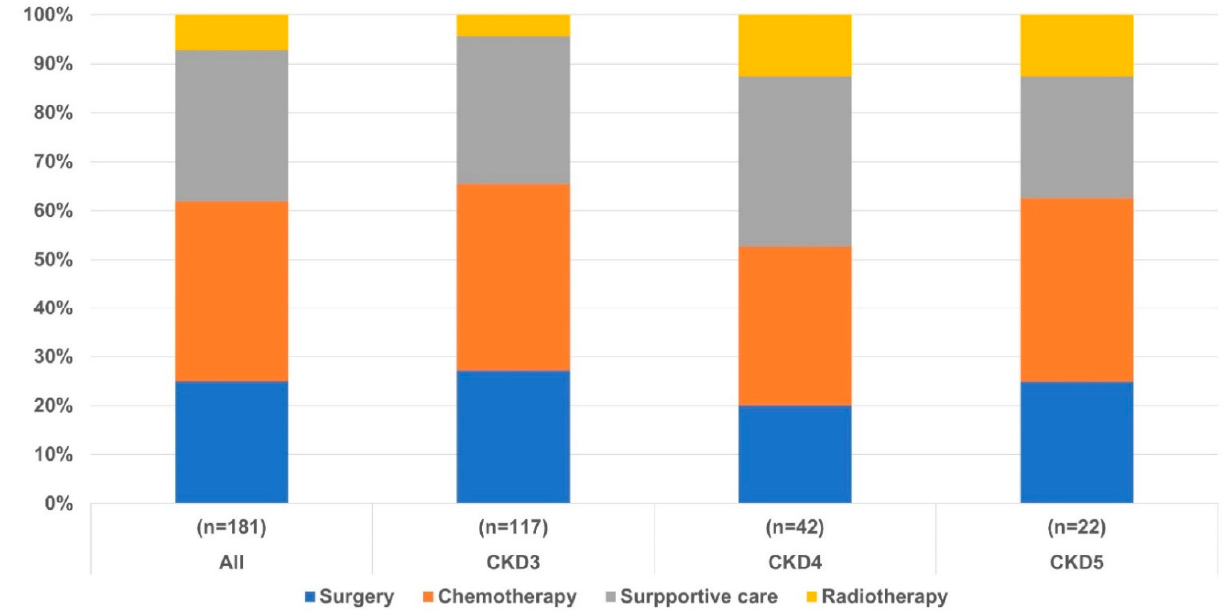
Figure 1. Selected treatment options for lung cancer according to CKD stage in early and advanced lung cancer stage. Table 1. Clinical characteristics and treatment of lung cancer patients with chronic kidney disease.